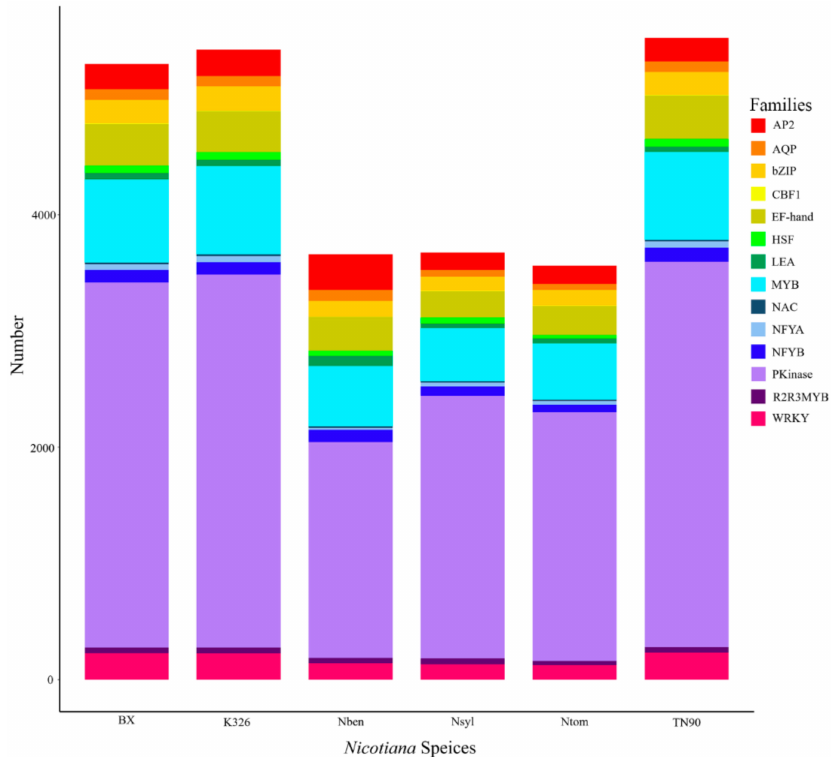
Figure 1. Distribution of resistance genes in the following Nicotiana species: BX, N. tabacum cv. Basma Xanthi; K326, N. tabacum cv. K326; Nsyl, N. sylvestris ; Nben, N. benthamiana ; Ntom, N. tomentosiformis ; TN90, N. tabacum cv.